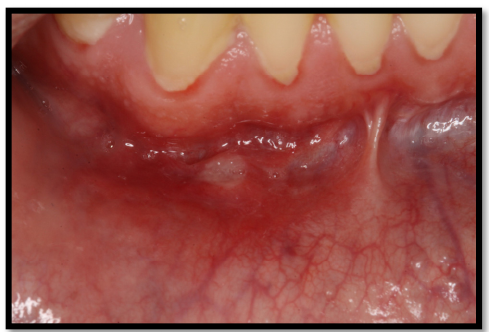
Figure 9. Minor aphthous ulcer in the lower vestibule mucosa.